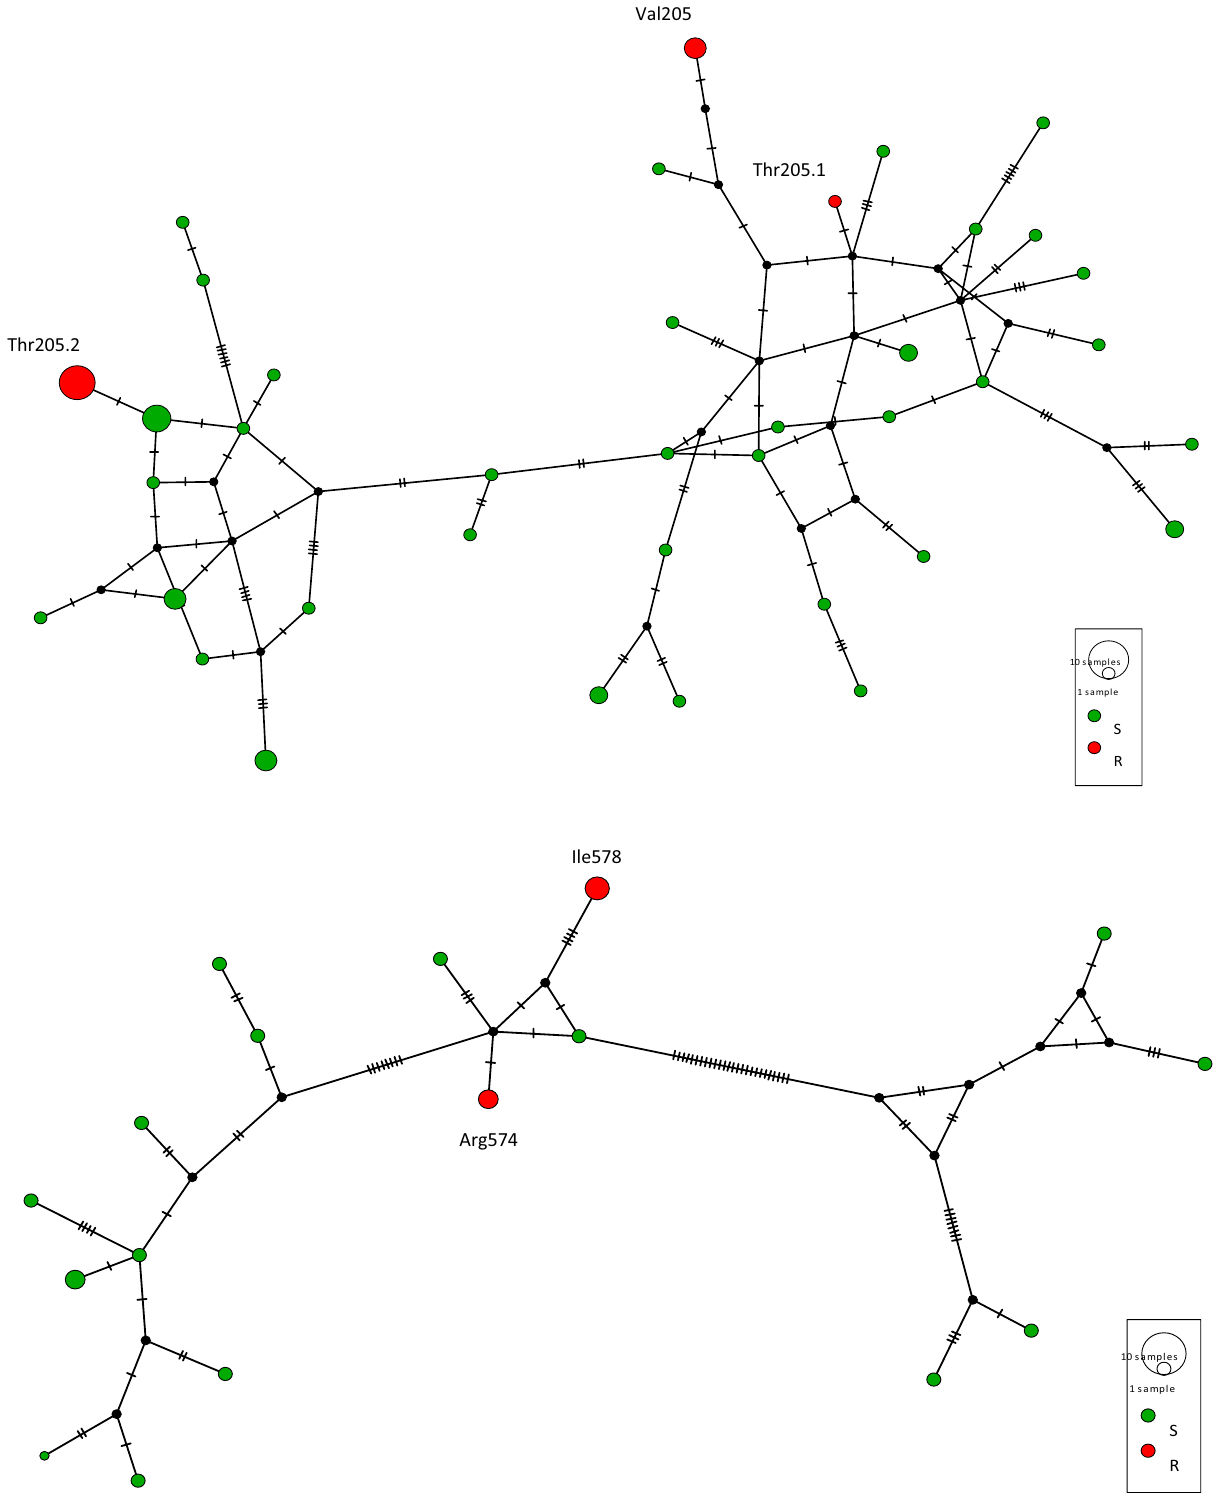
Figure 2. Haplotype network of the ALS haplotypes carrying a mutation at codon 205 (top), 574 or 578 (bottom) (red discs). Green discs, wild-type haplotypes (not carrying a mutation involved in herbicide